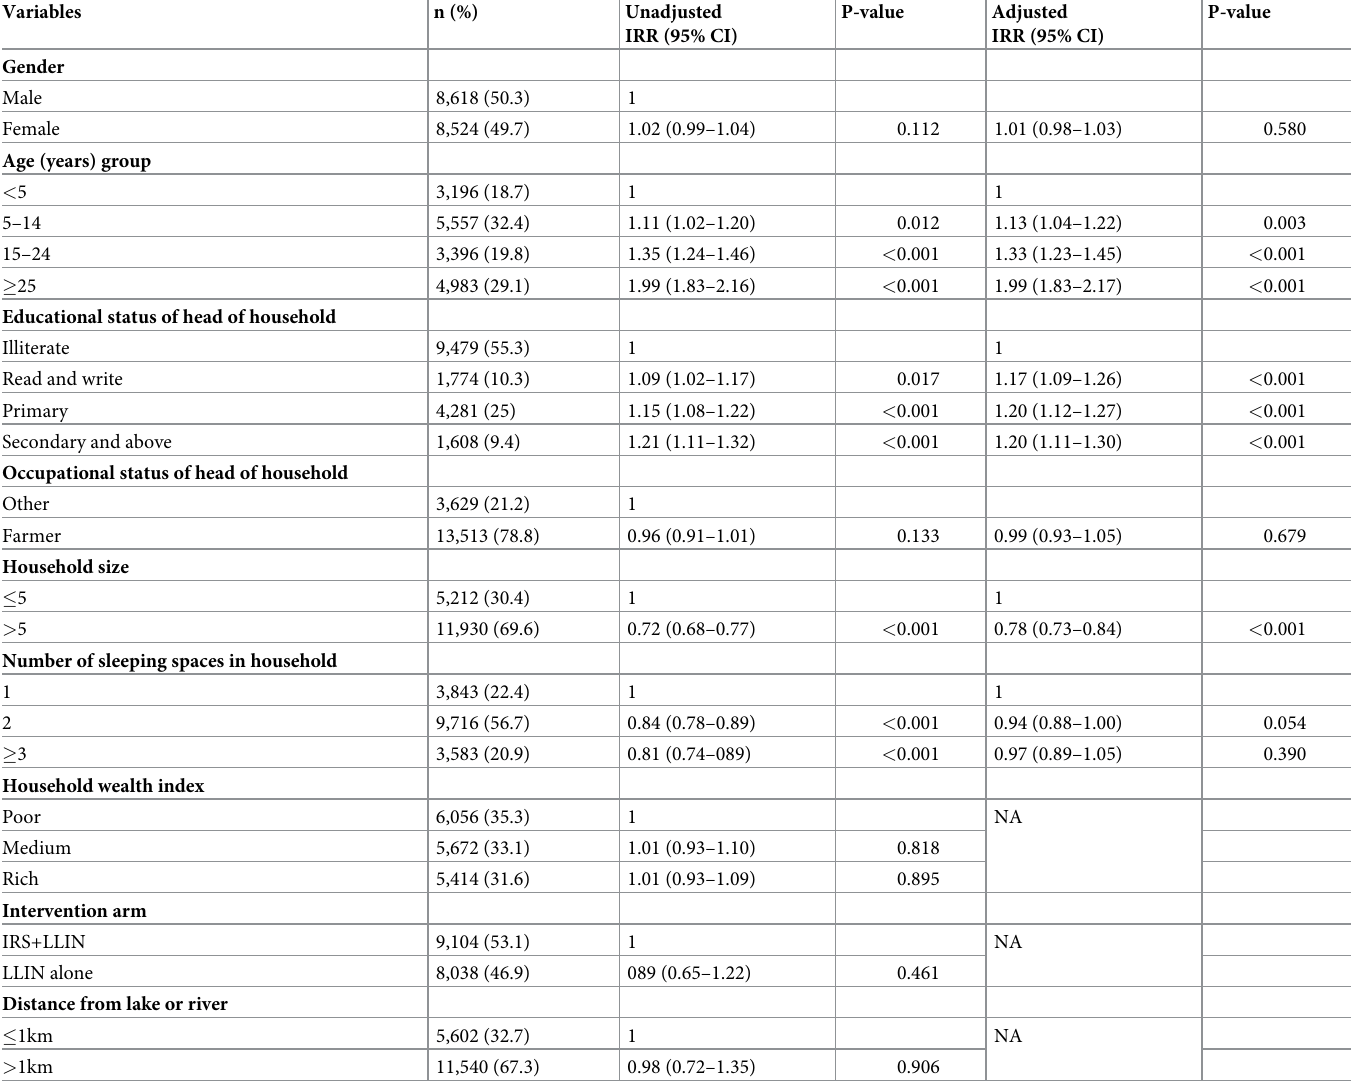
Table 5. Multilevel negative binomial regression for predictors of long-lasting insecticidal net use, during 121 weeks from October 2014 to January